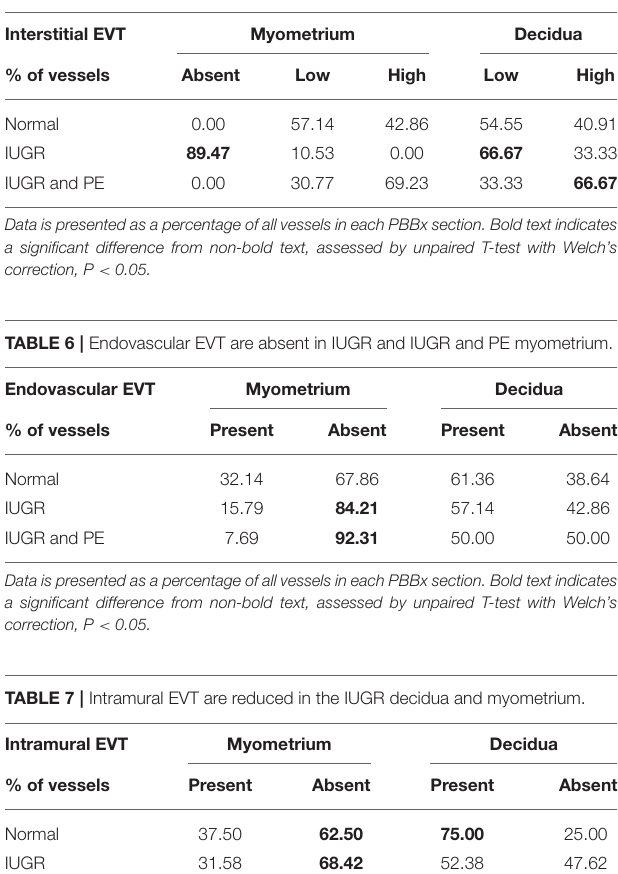
TABLE 5 | Interstitial EVT are reduced in the IUGR myometrium and decidua.